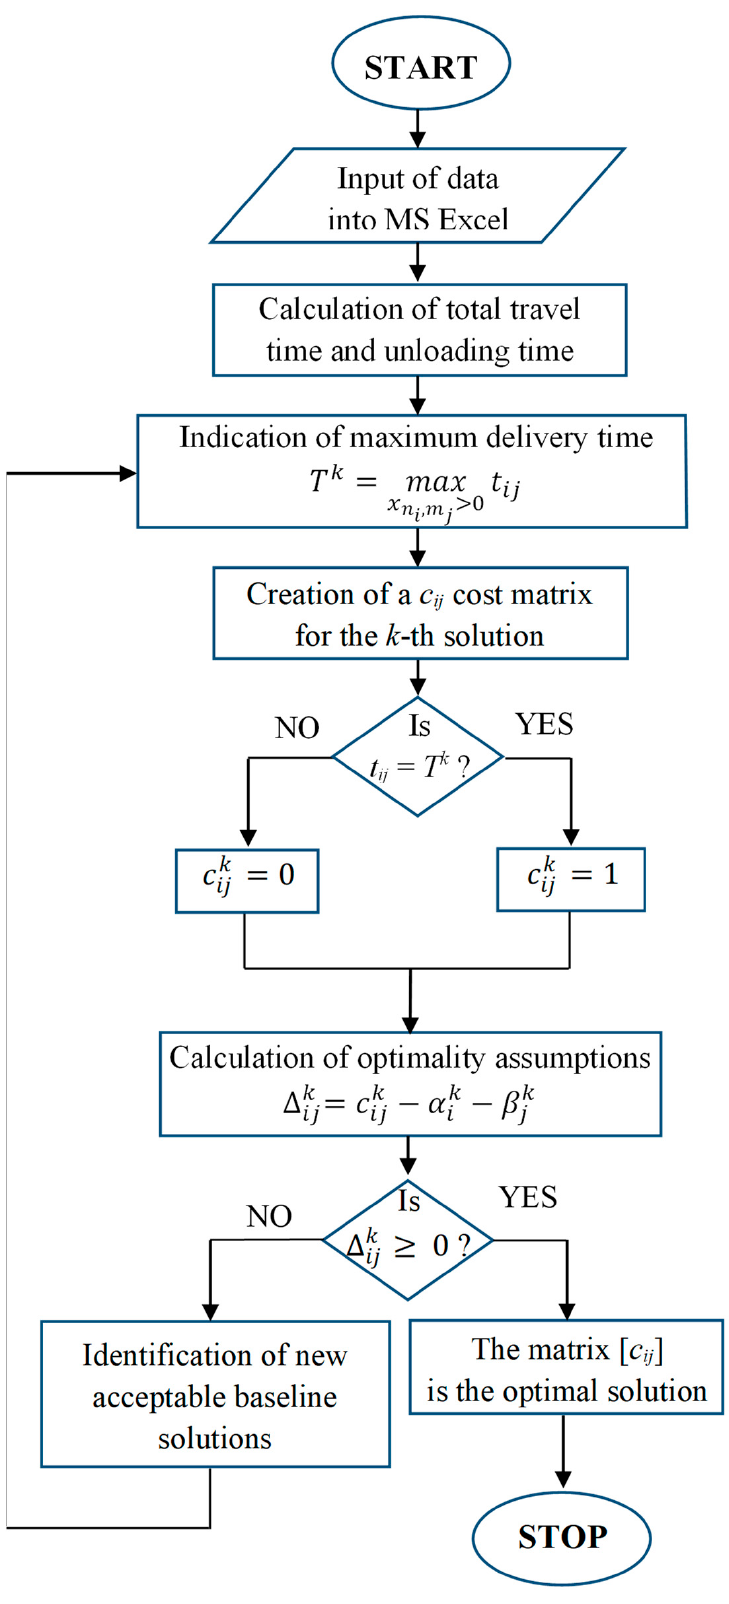
Figure 1. Procedure algorithm using MS Excel.